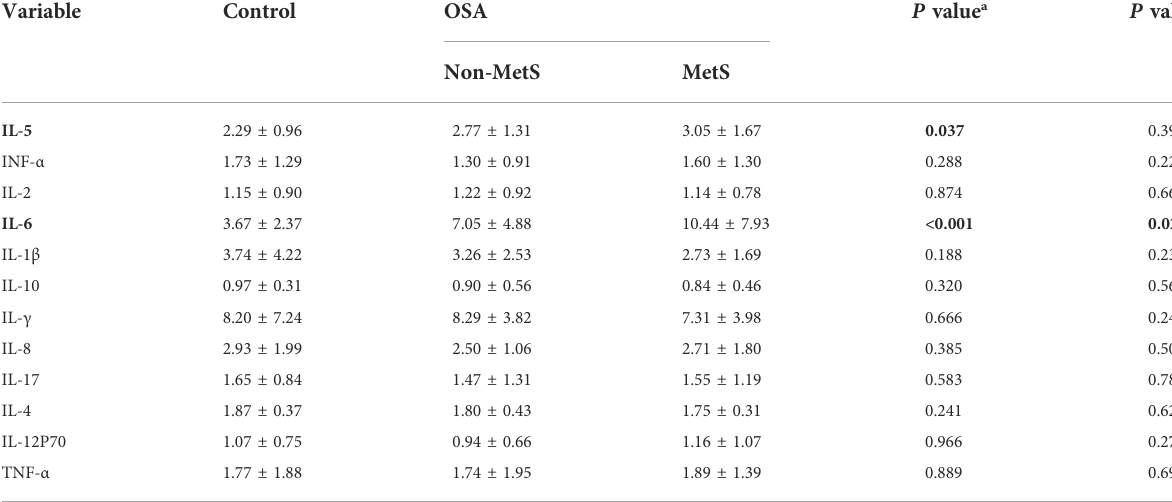
TABLE 2 Correlations of 12-cytokine levels with the presence of MetS in OSA patients.